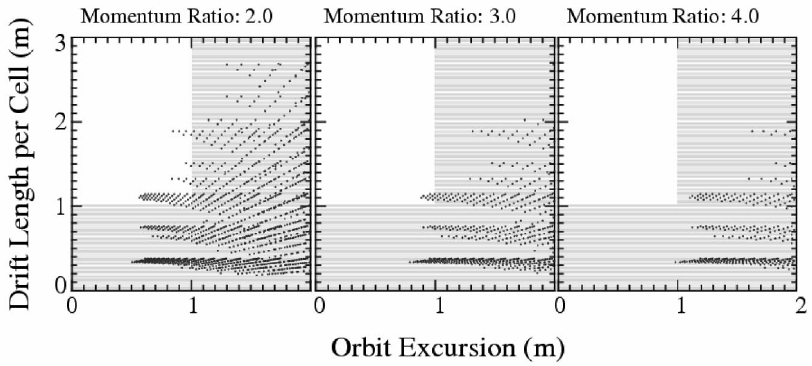
FIG. 5. Lengths of drift space per cell as a function of orbit excursion. Here, all the solutions satisfying a ring radius of less than 11 m are plotted. For momentum ratios above 3.0, fulfilling the constraints of both orbit excursion and drift length may not be possible.